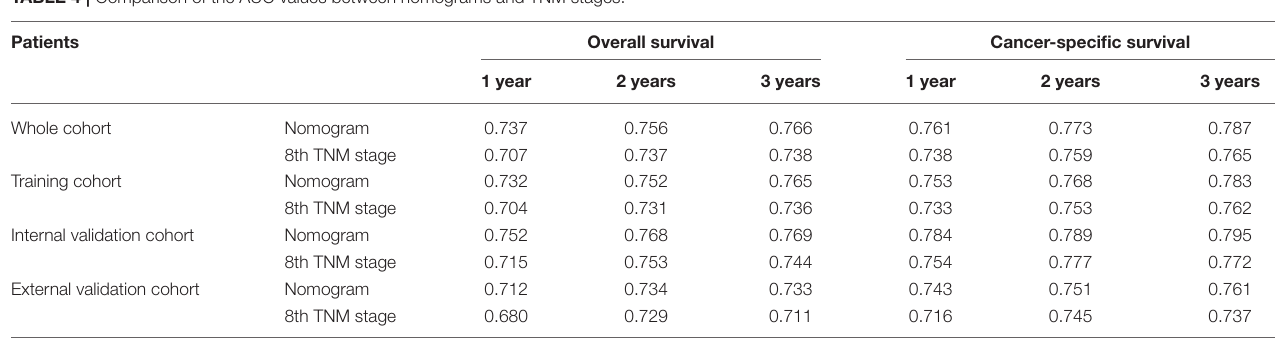
TABLE 4 | Comparison of the AUC values between nomograms and TNM stages. Patients Overall